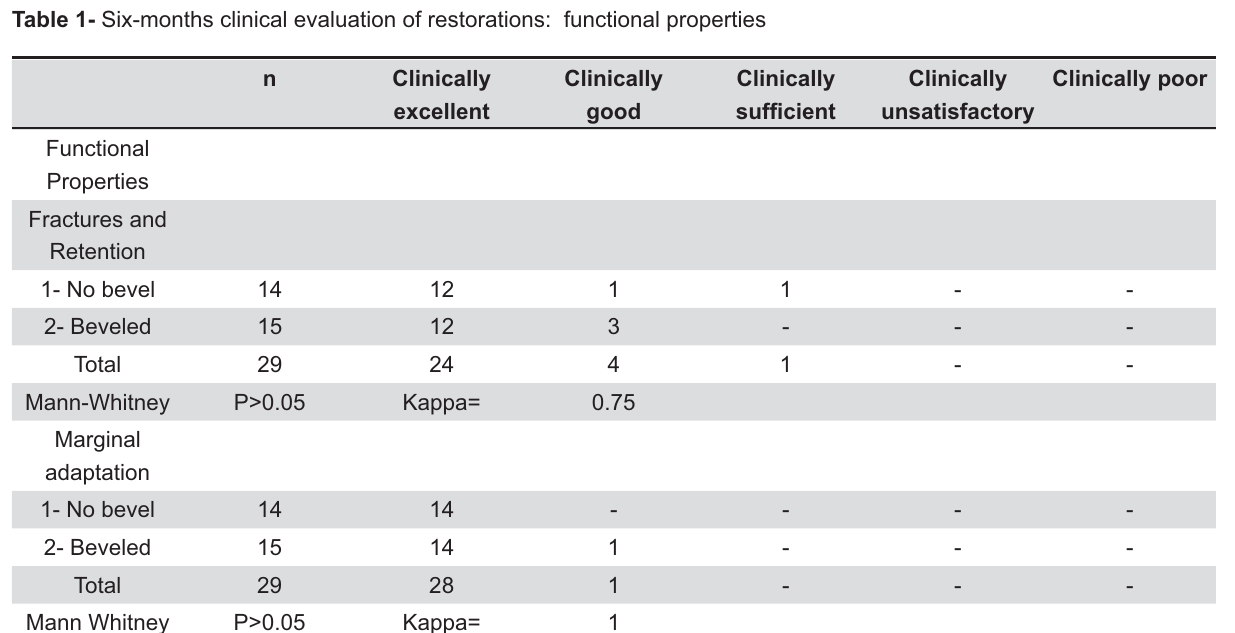
females, each one needing at least two Class I or II, in the mandible or maxilla. Patients with poor oral hygiene, parafunctional habits, tooth requiring large restorations and teeth without antagonist were excluded from the study.